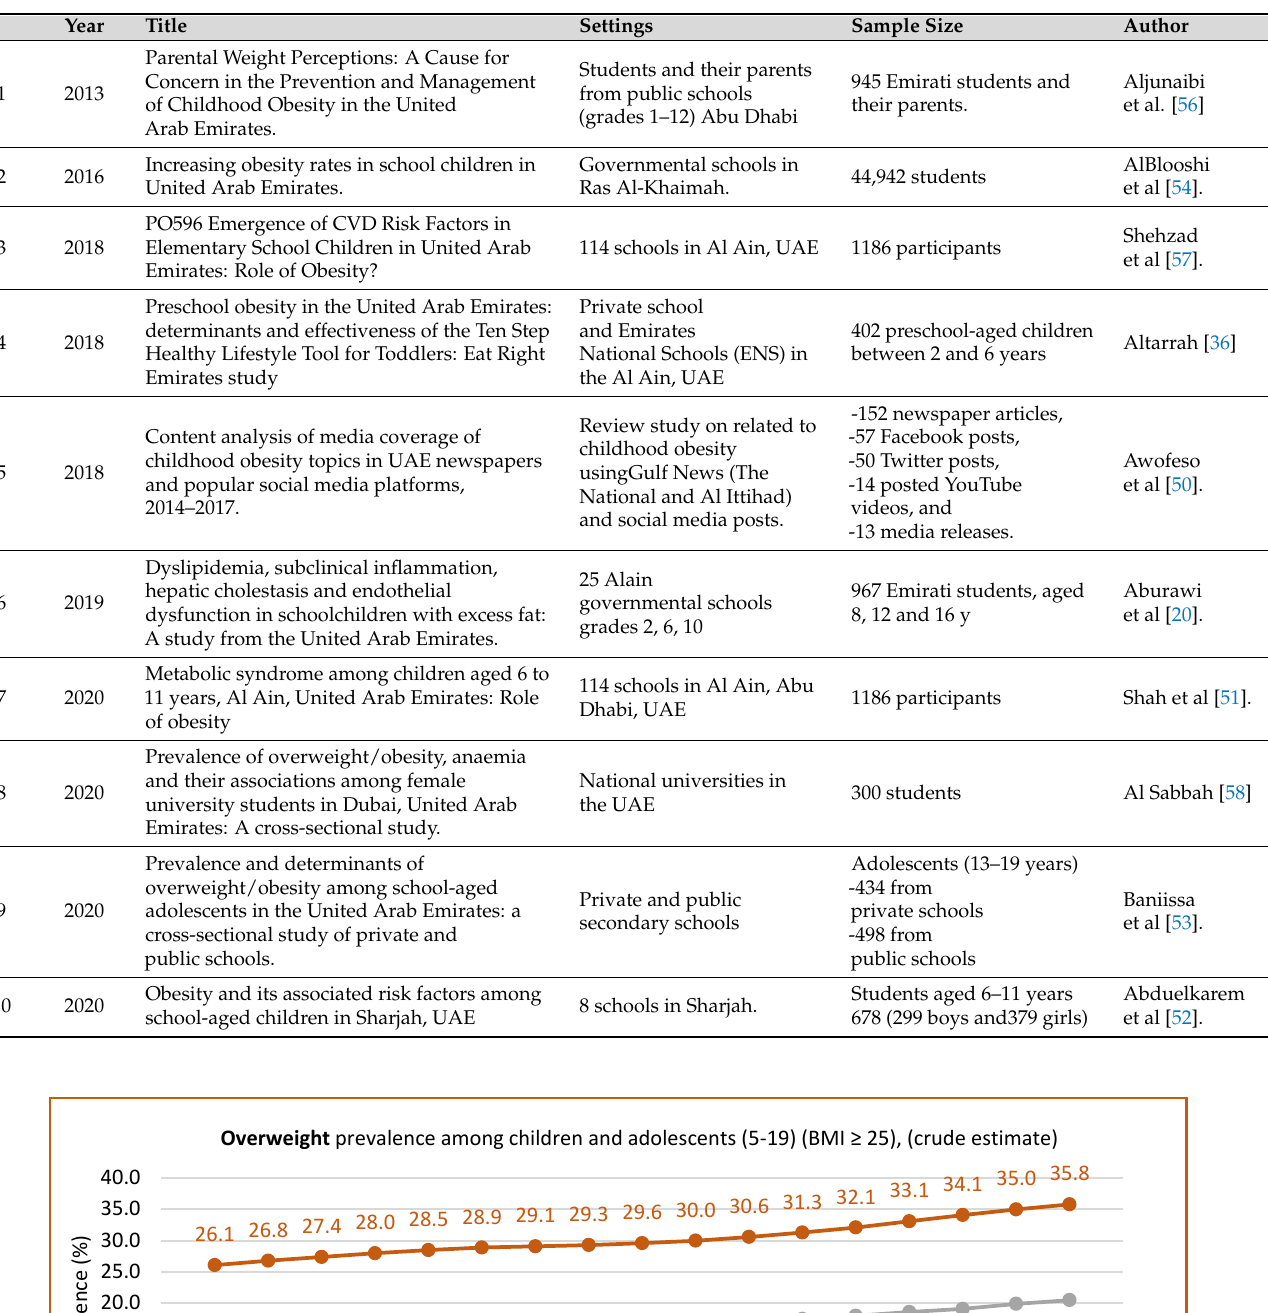
Table 2. Overweight and Obesity among Children.